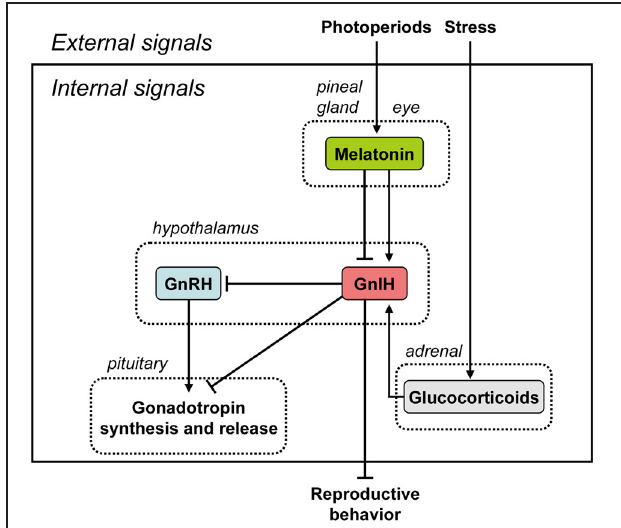
FIGURE 1 | Summary of the neuroendocrine integration of environmental signals and internal signals to control reproduction. The neuroendocrine integration of environmental signals, such as photoperiods and stress, and internal signals, such as GnIH, melatonin, and glucocorticoids, is important for the control of avian and mammalian reproduction. GnIH inhibits gonadotropin synthesis and release by directly acting on the pituitary or by inhibiting the activity of GnRH neurons in birds and mammals. GnIH can also inhibit reproductive behavior by possibly acting within the brain. GnIH expression is photoperiodically modulated via a melatonin-dependent process. Melatonin induces the expression of GnIH in quail and rats, whereas melatonin inhibits the expression of GnIH in hamsters and sheep. Stress induces the expression of GnIH in birds and mammals. GnIH may therefore be a mediator of stress-induced reproductive disruption. See the text for